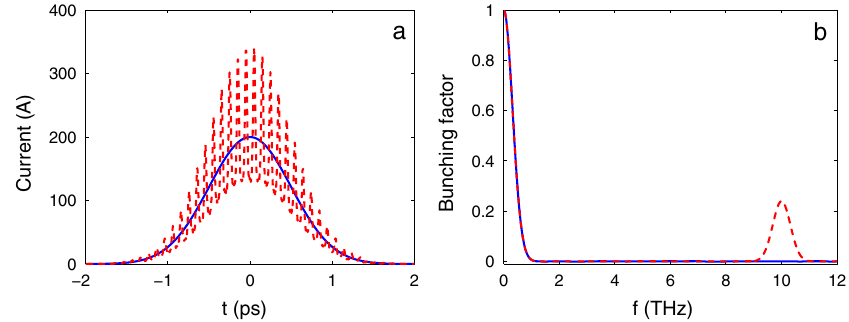
FIG. 6. (Color) (a) Initial current distribution (solid blue line) and that after the dispersion section (dashed red line). (b) Corresponding bunching factor for the initial current distribution (solid blue line) and that after the dispersion section (dashed red